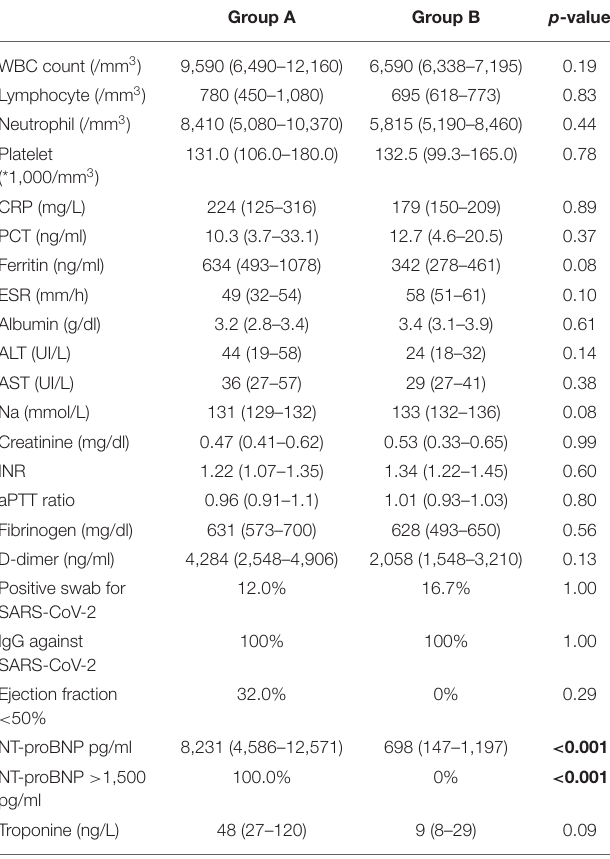
TABLE 2 | Laboratory features of Group A and Group B. TABLE 3 | Outcomes and concomitant hematological treatment of Group A, Group B, and overall